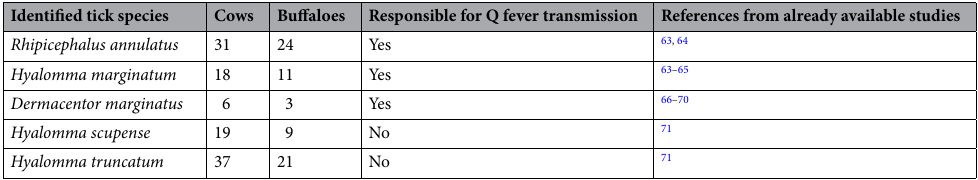
Table 6. Identified tick species from cattle and buffaloes.